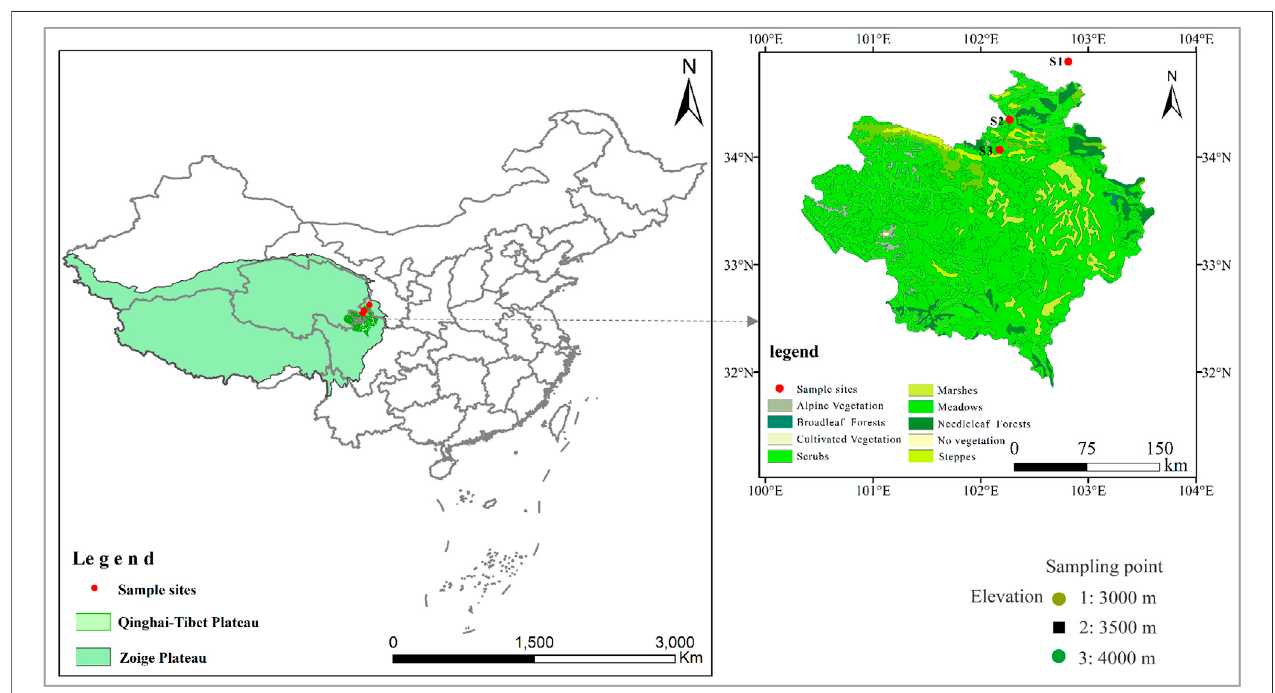
FIGURE 1 | Schematic of the study area and sampling